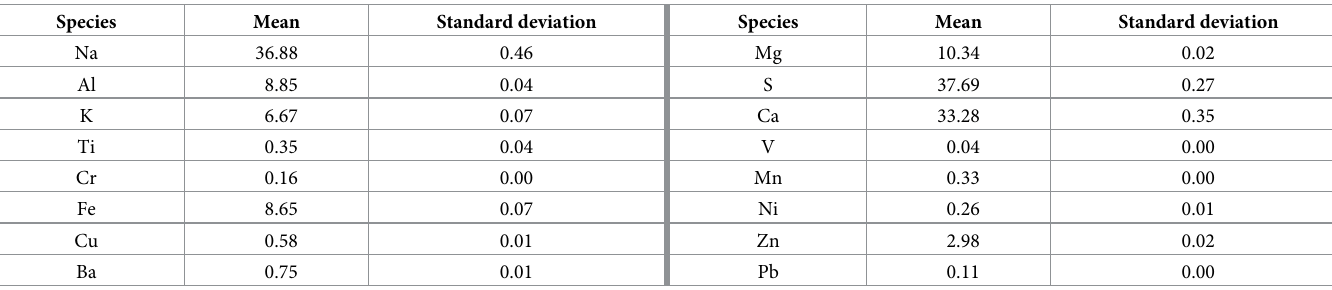
Table 1. Mass fraction of the elements and metals (ng/ μ g PM) during exposures.